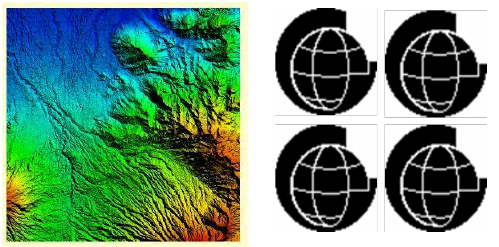
Figure 12. Watermarking results using the 2D DCT algorithm; 100% watermark image extracted with 2D DCT applies equally to all image areas.